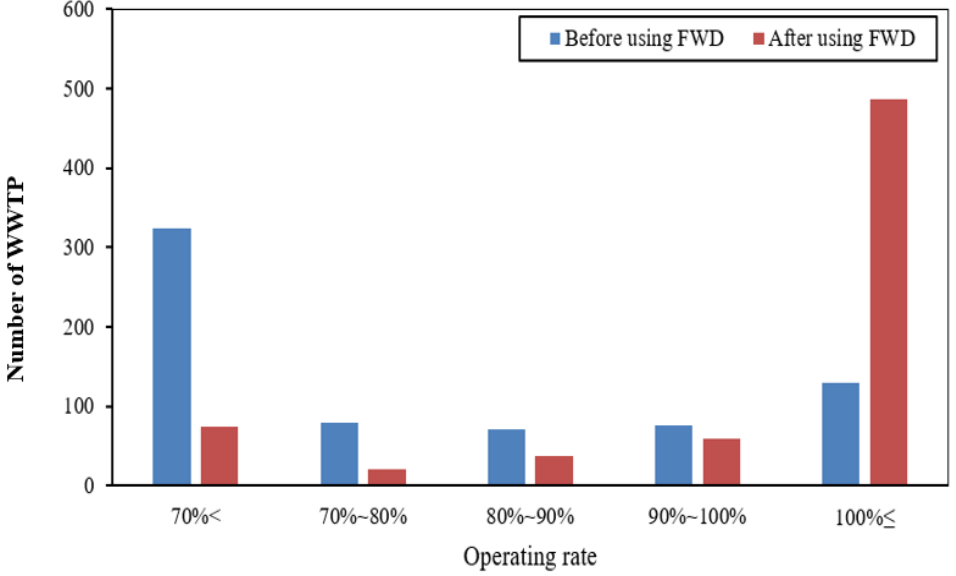
Figure 5. Changes in the WWTP utilization rate before and after the FWD introduction .